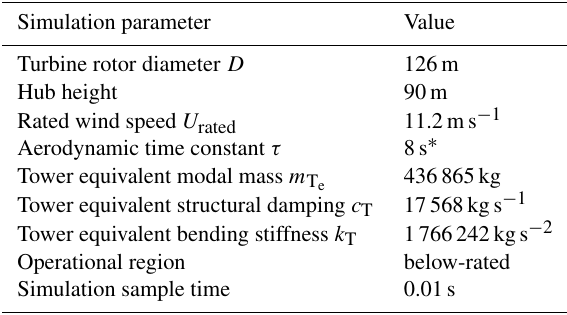
Table 1. Specifications of the wind turbine models taken from Jonkman and Buhl